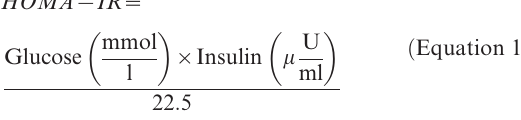
Table 1. Descriptive characteristics of the cohorts of Greek and Swedish children and adolescents.